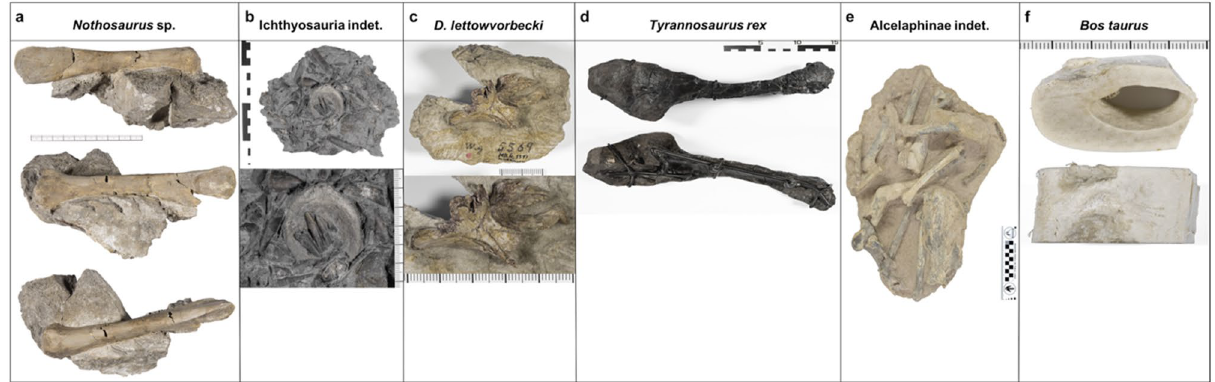
Figure 1. Photographs of investigated objects. In the horizontal, the objects are divided into marine and terrestrial animals and listed in order of their geological time periods. Photographs of the investigated marine ( a , b ) and terrestrial ( c – f ) objects. Photographs of the calibration objects, the haemal arch of the Tyrannosaurus rex MB.R. 5742.1 and leg bone of Bos taurus MB.Ma. 52910 ( d , f ), were taken after bone fragment removal. The test objects include Nothosaurus sp. MB.R. 2830 and Ichthyosauria indet. MB.R. 3538.3 ( a , b ) and Dysalotosaurus lettowvorbecki MB.R. 1317 and Alcelaphinae indet MB.Ma. 51906 ( c , e